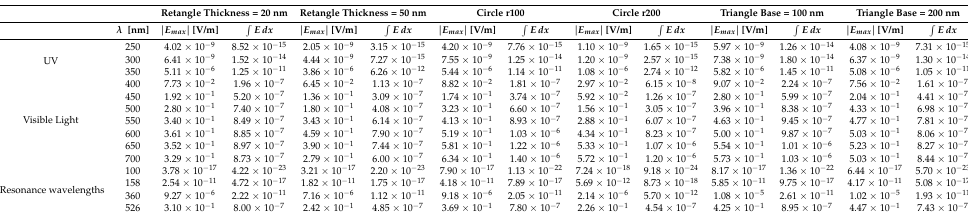
Table A11. Summary table of the results obtained for the copper nanostructures—Probe 2. RetangleThickness=20nm RetangleThickness=50nm